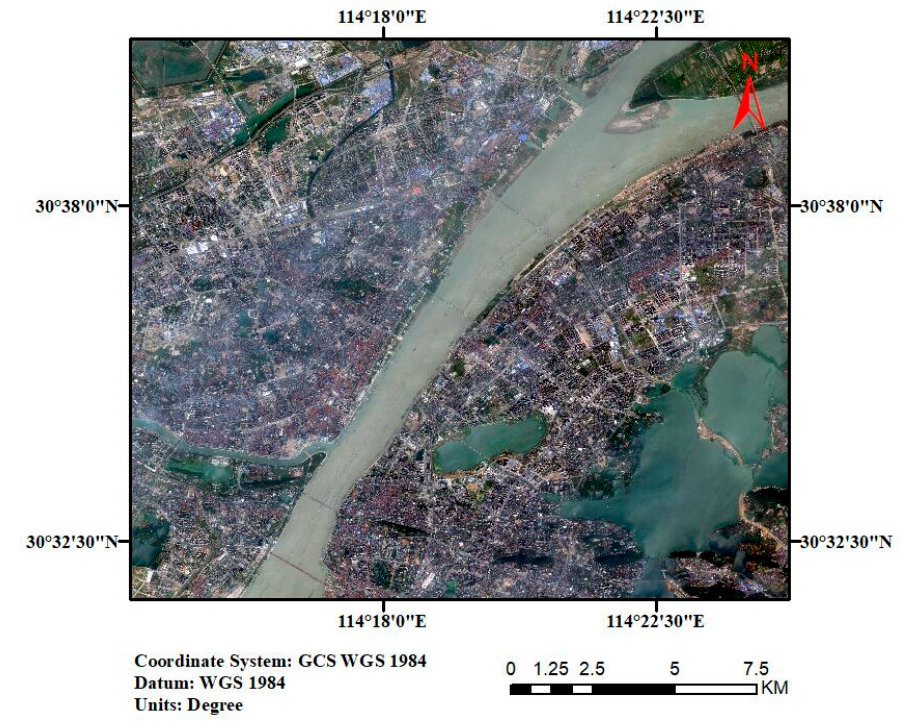
Figure 2. GaoFen-2 image of the study area.